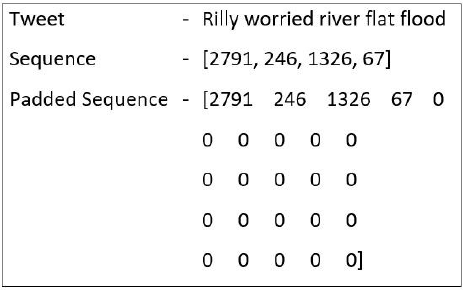
Fig 3. Converting text to